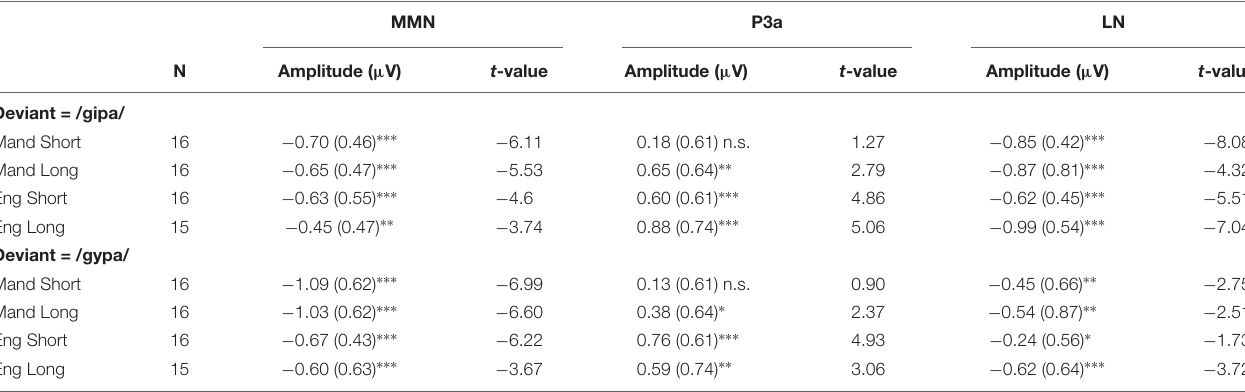
TABLE 2 | Means (SD) of the average amplitude for the peak 40-ms interval and t -test (one-tailed) results of MMN, P3a and LN components for the four language/ISI groups under /gipa/ deviant and /gypa/ deviant conditions. MMN